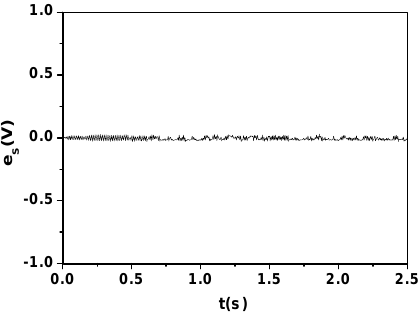
Fig. 17. Error function based on the SM − BNDRLMS algorithm for the case C 4 .